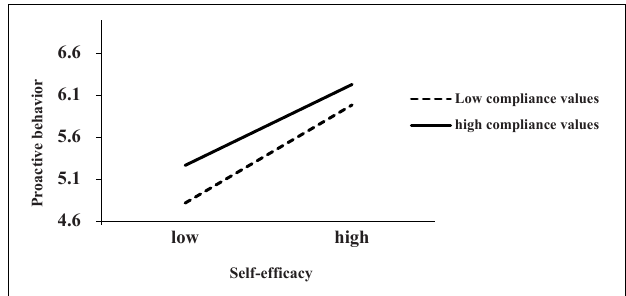
FIGURE 2 | Interaction effect of self-efficacy and proactive behavior on conformity